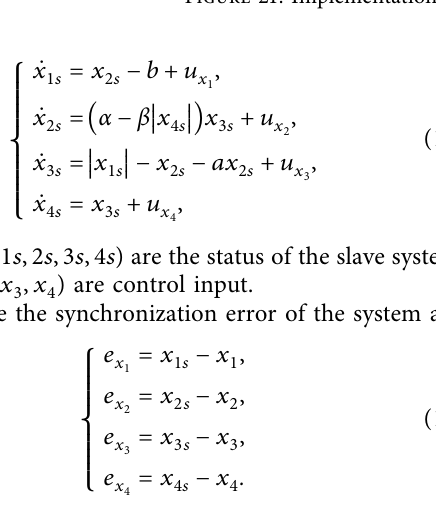
Figure 21: Implementation of FPGA digital circuit of the